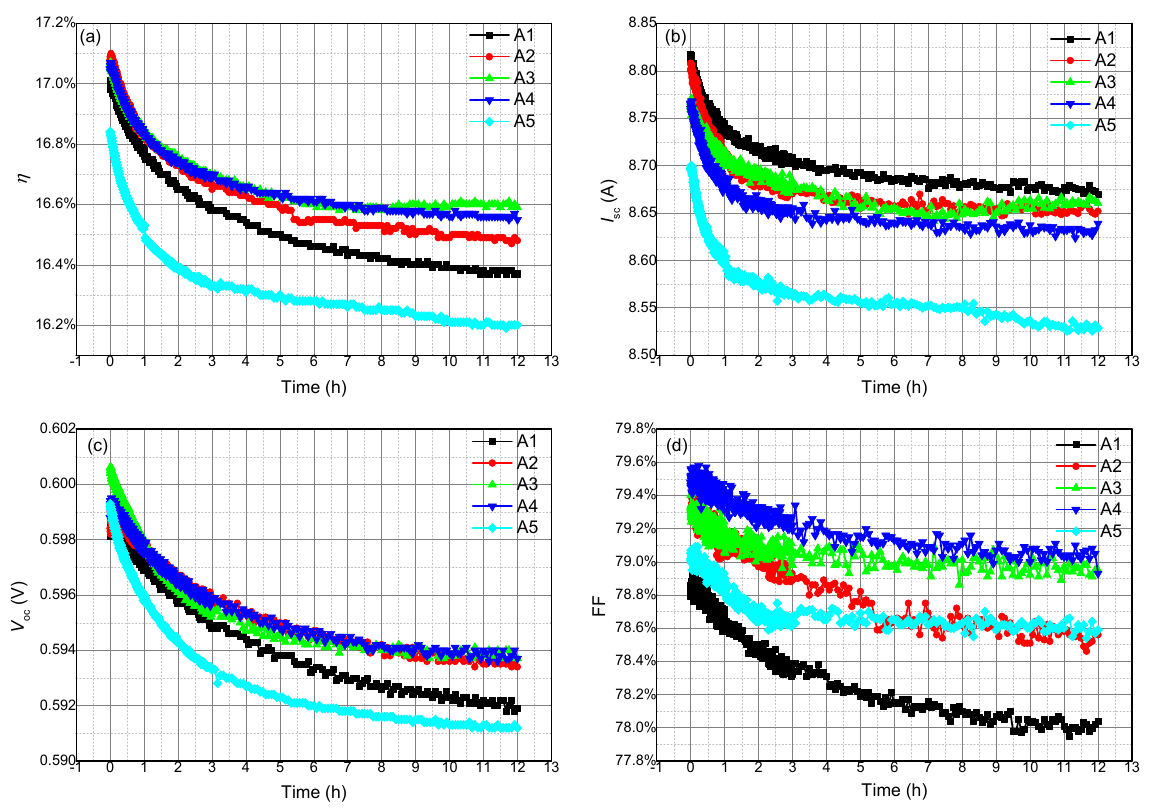
Figure 1. In-situ changes of illuminated I - V characteristic parameters of the five groups of Al-BSF solar cells with processing time within the 1st LID (45 °C, 1 sun, 12 h). ( a ) efficiency; ( b ) short-circuit current; ( c ) open-circuit voltage; ( d ) fill factor.